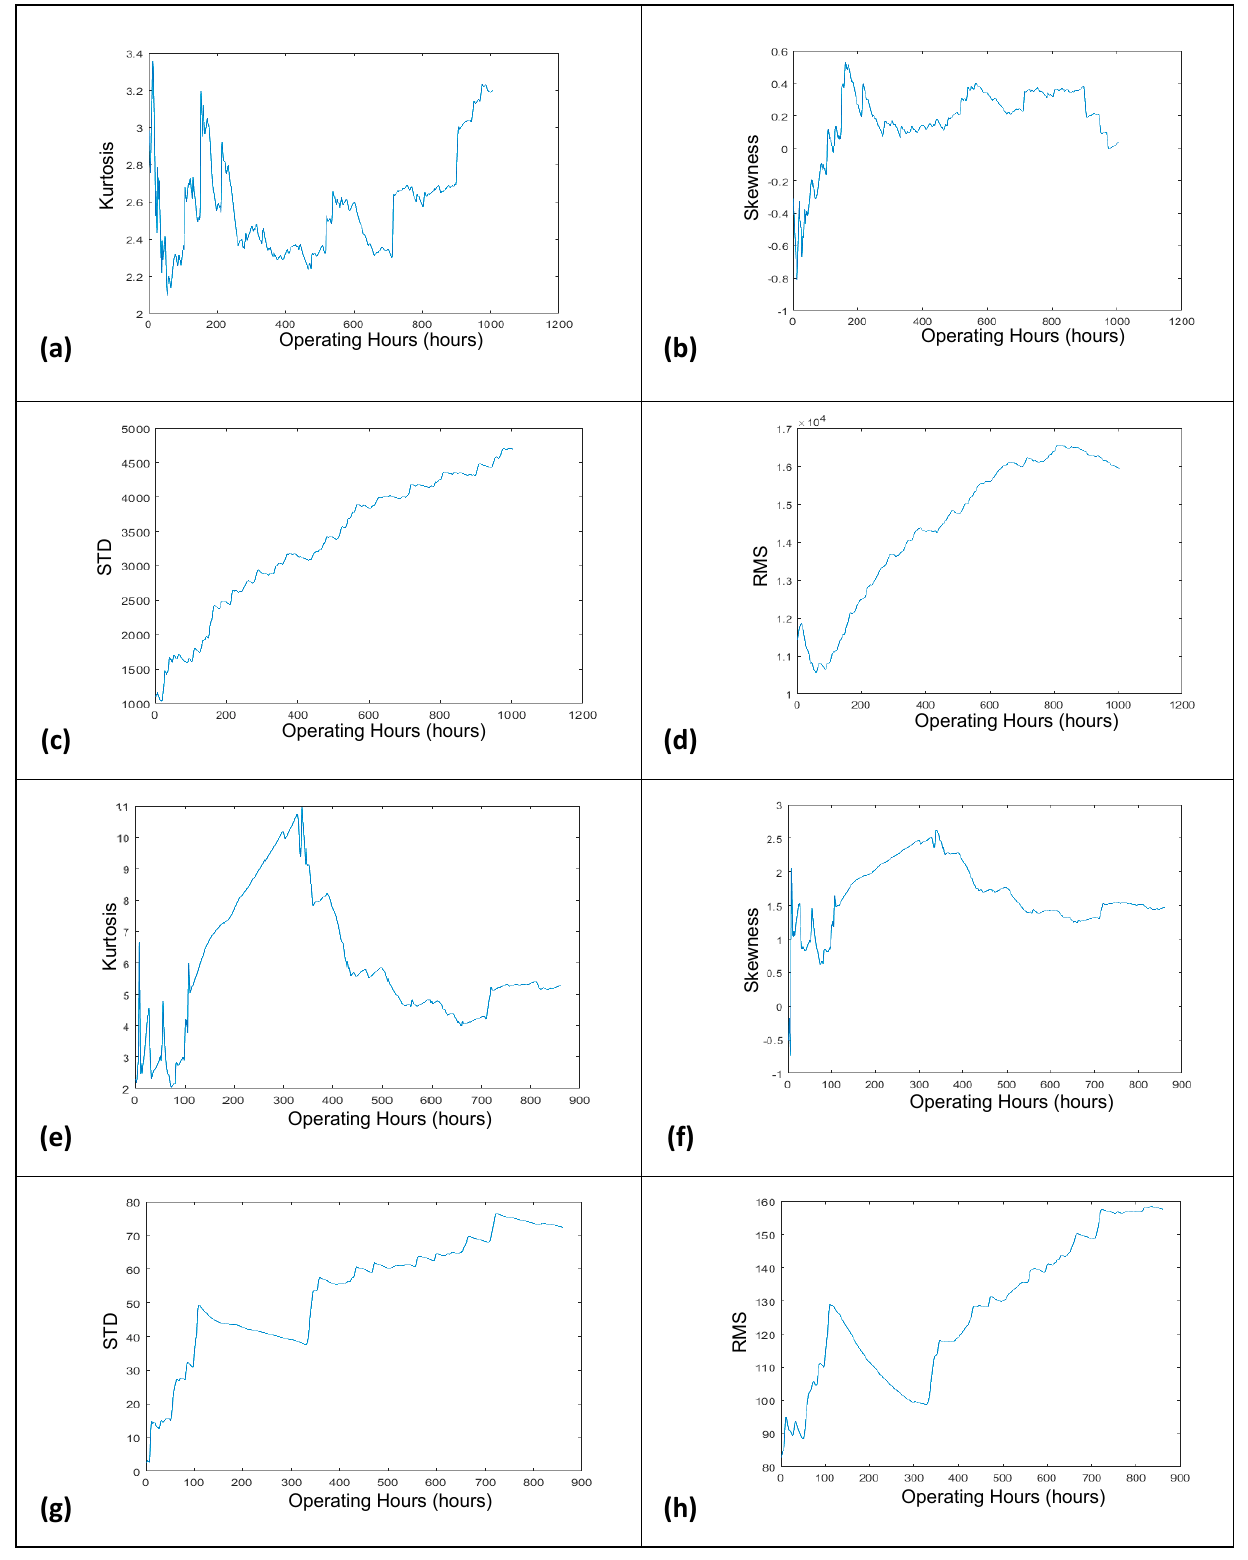
Figure 9. Degradation trends generated by kurtosis, skewness, St. deviation, and RMS using dataset 2014 ( a – d ), and dataset 2017 ( e – h ), for channel